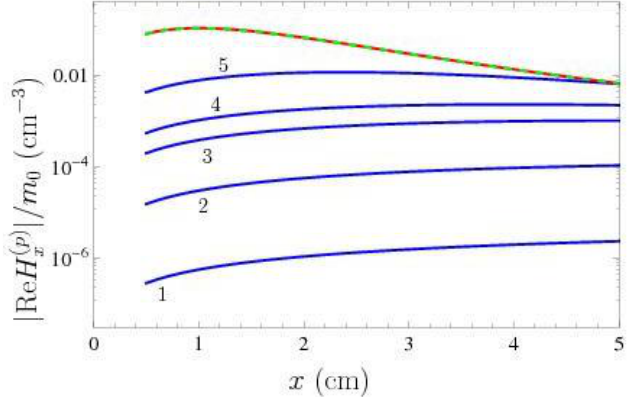
Figure 2. The normalized magnitude of real part of the lateral component of monochromatic magnetic field reflected from the copper plate computed using the Drude model as the function of separation from the magnetic dipole at the dipole height of 1 cm above a plate is shown by the solid lines labeled 1, 2, 3, 4, and 5 for the oscillation frequency equal to 0.2, 2, 10, 20, and 100 rad/s, respectively. The top solid and overlapping with it dashed lines are computed using the plasma and spatially nonlocal models.